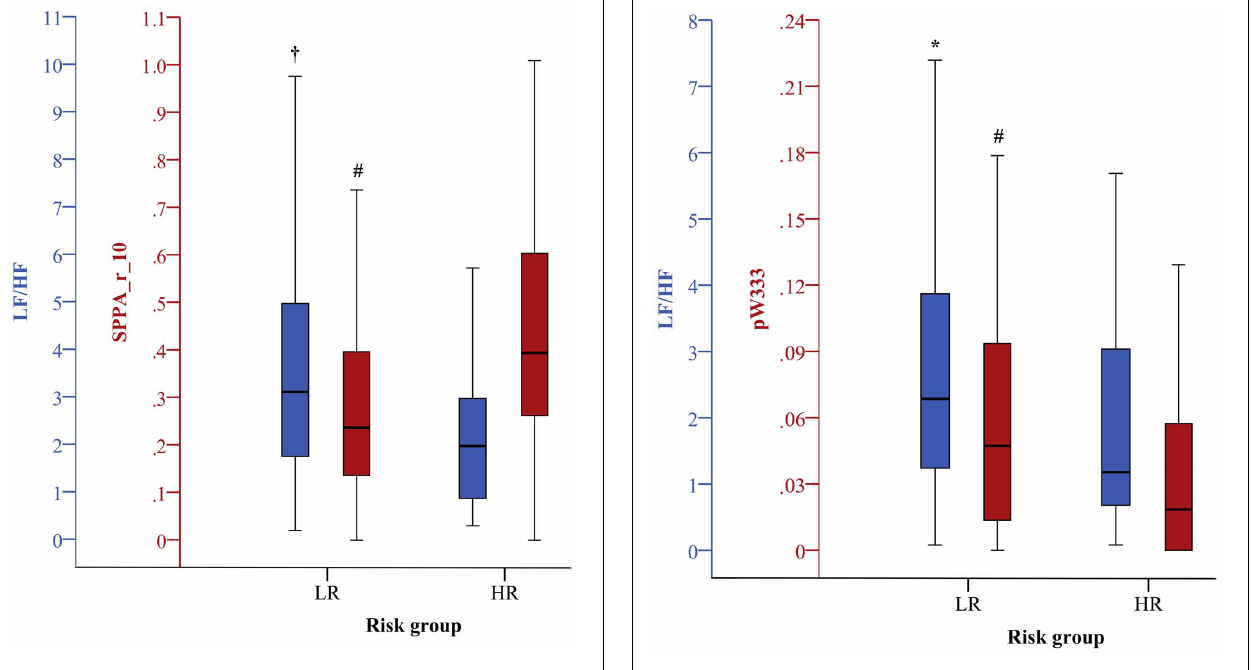
FIGURE 4 | Boxplots of the most significant univariate clinical, linear, and nonlinear indices (30min night phase) discriminating low (LR) and high (HR) risk groups ( ∗ p < 0 . 05; # p < 0 .